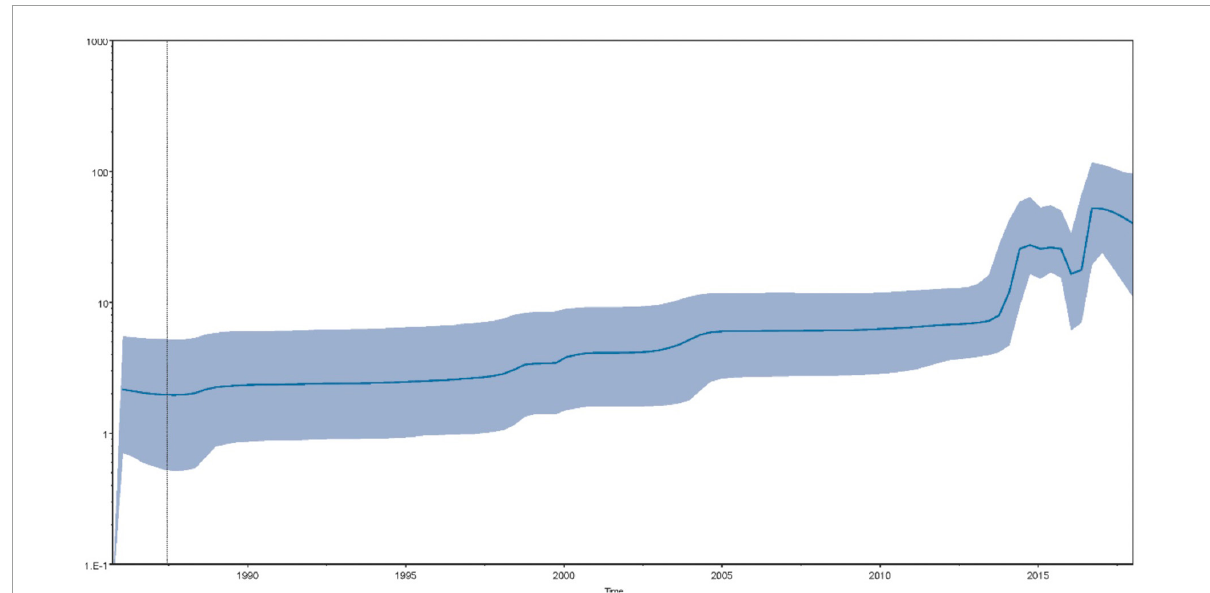
FIGURE3 The Bayesian skyline plot depicts the temporal variation of the effective population size of SVA. The x-axis shows the time (year) and the y-axis indicates the product of the generation length in years and the effective population size. The dark blue solid line represents the median of the effective population size and the light blue shaded area indicates the 95%